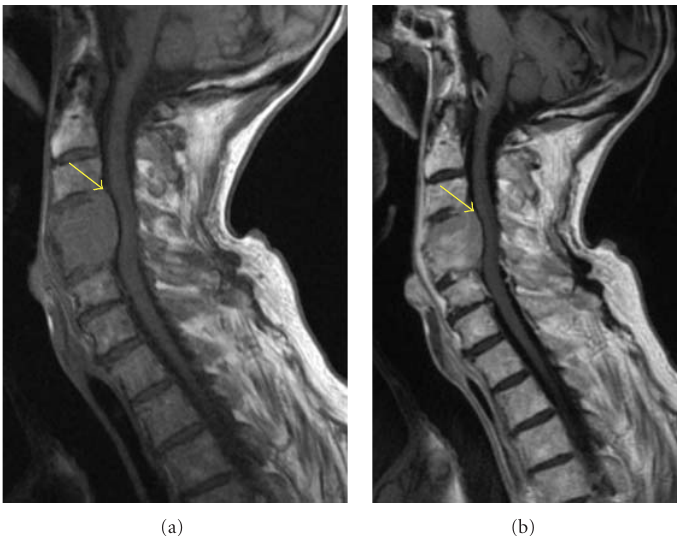
Figure 7: Sagittal T1-weighted MR image (a) shows a hypointense expansile lesion involving the C4 and C5 vertebral bodies with extension into the ventral epidural space (yellow arrow). The lesion enhances homogeneously on postcontrast T1-weighted MR (b); however, the degree of normal marrow enhancement is similar to that of the metastatic myeloma